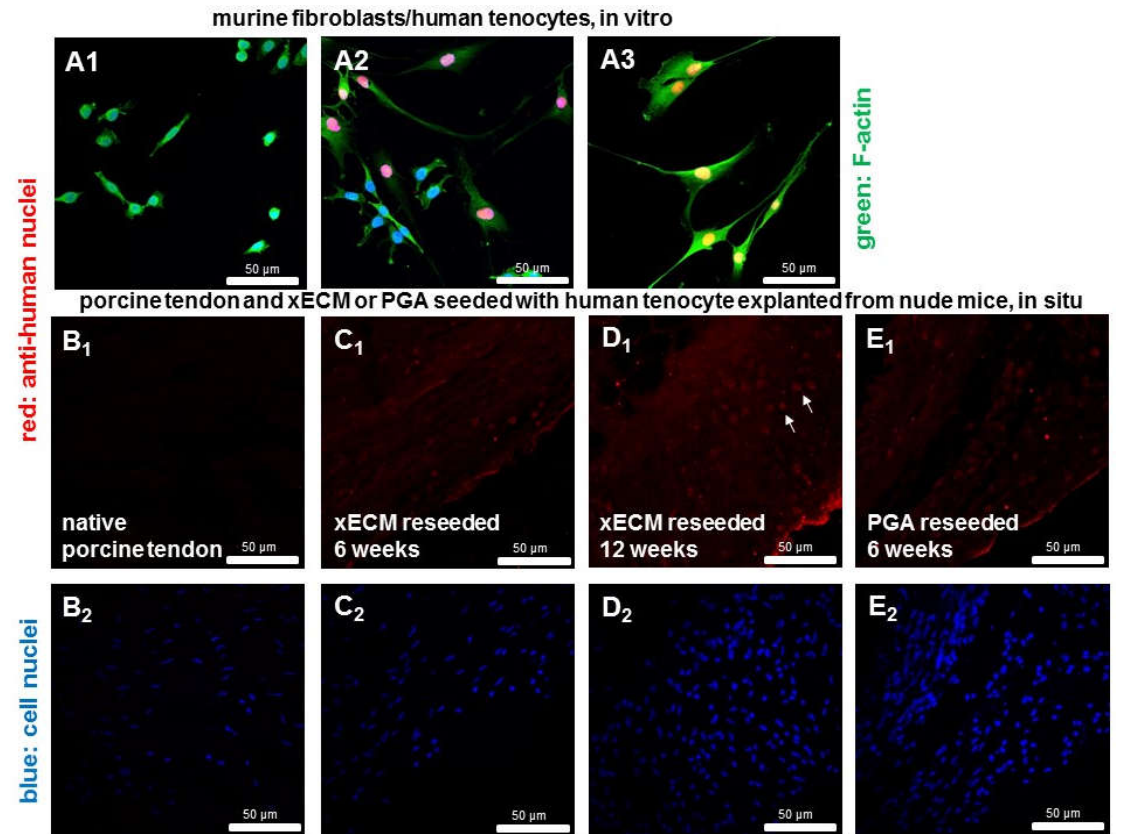
Figure 8. Detection of human cell nuclei recellularized xECM in vivo six and 12 weeks after implantation in the nude mice. ( A 1–3 ) Human hamstring tenocytes and the murine subcutaneous fibroblast cell line (L929) were immunolabeled for human cell nuclei (48 h of culture). ( A 1 ) L929, ( A 2 ) co-culture consisting of L929 and human tendon fibroblasts and ( A 3 ) human tendon fibroblasts. ( A 1 –A 3 ) Green, Phalloidin-Alexa488 staining of F-actin cytoskeleton. ( A 1– E 1 ) Anti-human cell nuclei immunolabeling (red) to mark human-derived cell nuclei. ( A 1–3 , B 2 – E 2 ) DAPI staining to show all cell nuclei. ( B 1–2 ) Native porcine AS tendon, ( C , D ) xECM decellularized and recellularized with human tenocytes and implanted in nude mice for six ( C ) and 12 weeks ( D ), immunolabeled for anti-human nuclei and Cy3-coupled secondary antibody. D 1 : arrows mark cell nuclei (red) of human cells. ( E 1–2 ) PGA recellularized for six weeks.